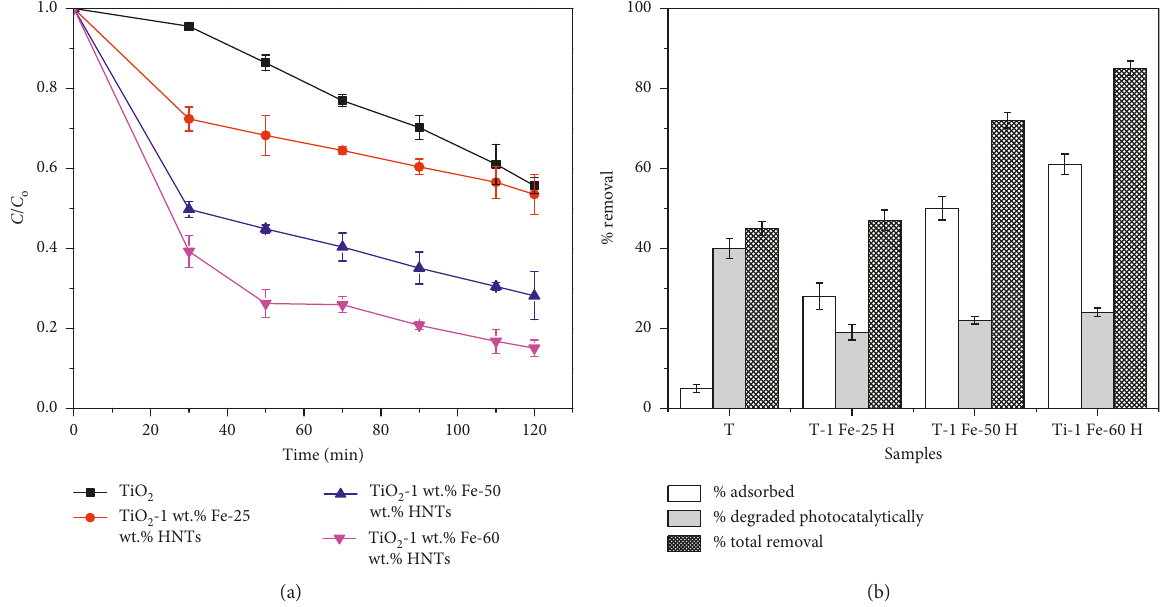
Figure 1: (a) Photocatalytic degradation and adsorption of methylene blue by TiO the synthesized TiO 2 and TiO 2 -Fe-HNTs (T: TiO 2 ; T-Fe-H: TiO 2 -Fe-HNT composite).